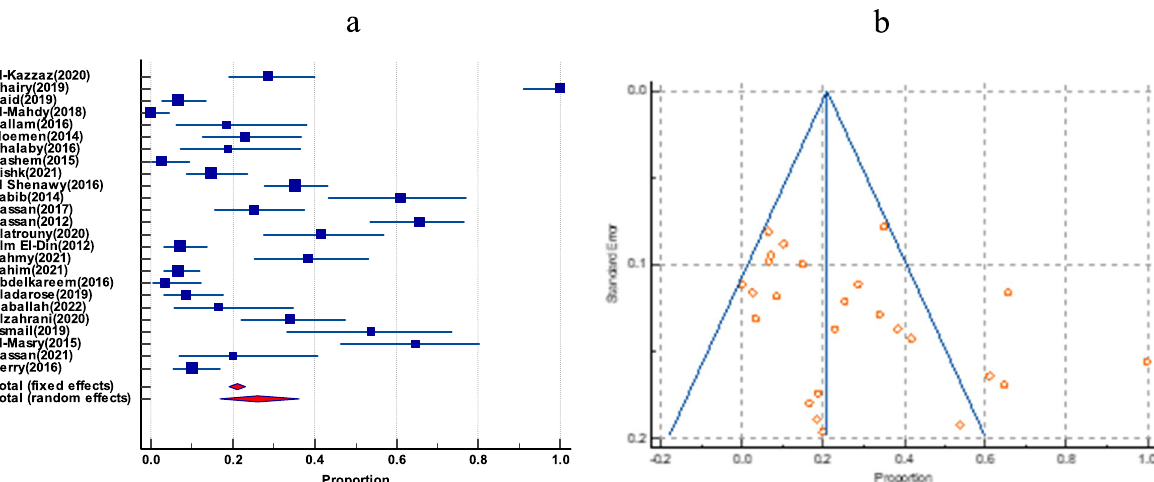
Fig. 2 The prevalence of VRE among clinical isolates in Egypt. a Forest plot of VRE among total enterococci. b Funnel plot of VRE among total